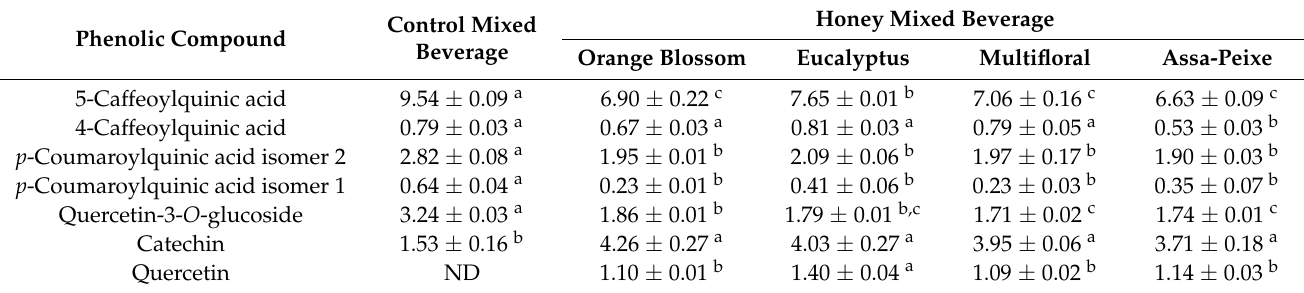
Table 3. Phenolic compound contents (mg/100 mL) of the control mixed beverage and the honey mixed beverages. Honey Mixed Beverage Control Mixed Phenolic Compound Beverage Orange Blossom Eucalyptus Multifloral